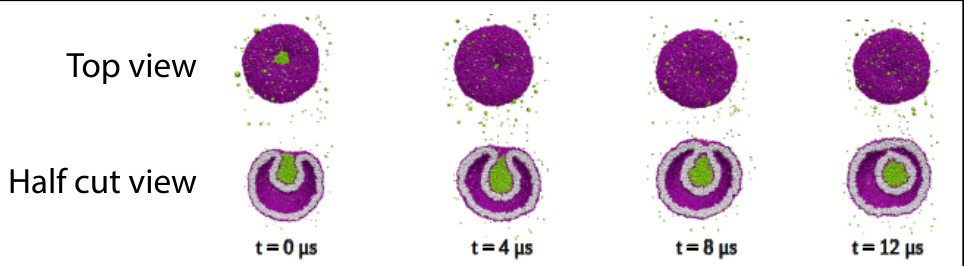
Figure 27. Endocytosis of condensate droplet (green) with complete engulfment of the droplet followed by division of the nanovesicle membrane (purple-grey) into two nested daughter vesicles as observed in molecular dynamics simulations [30]. In this example, the bilayer membrane consists of 5500 lipids in the outer and 4600 lipids in the inner leaflet. The contact line between membrane and droplet has a positive line tension λ (cid:39) + 7 k B T / d . The membrane neck closes at t = 4 µ s and undergoes fission at t = 9 µ s, generating a small intraluminal vesicle around the droplet. The undivided nanovesicle has a size of 37nm, the droplet has a diameter of